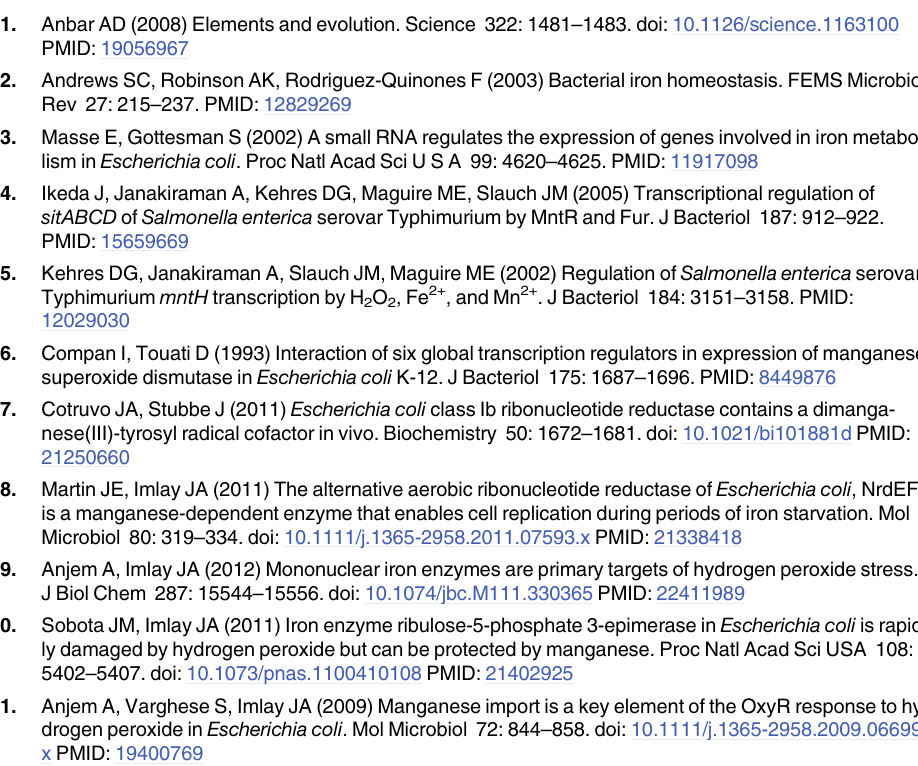
S2 Table. Primers used in site-directed mutagenesis. S3 Table. Heme proteins of Escherichia coli K-12. Non-K-12 strains additionally express (CybC) and ferrous iron transporter (EfeUOB), heme-containing soluble cytochrome b 562 both of which are cryptic in K-12 strains. E . coli K-12 synthesizes two proteins with siroheme cofactors: sulfite reductase and soluble nitrite reductase (NirB). Ferrochelatase is not involved in siroheme